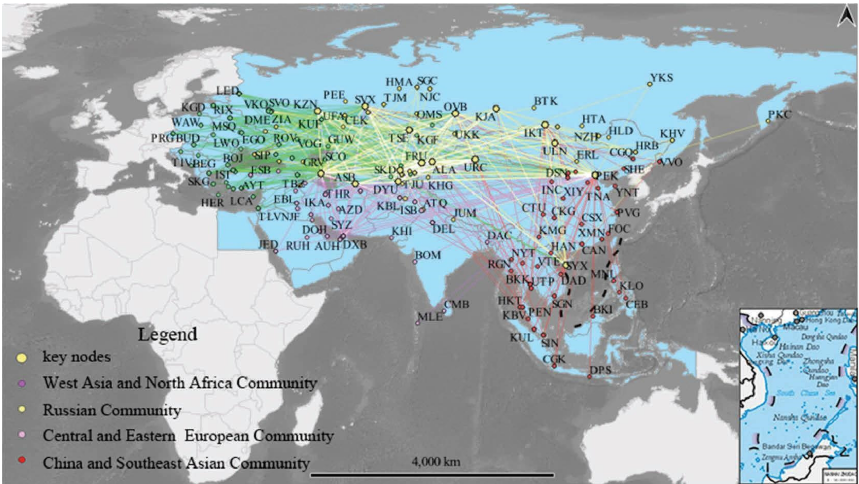
Figure 10: International routes of key node set in Russian community.